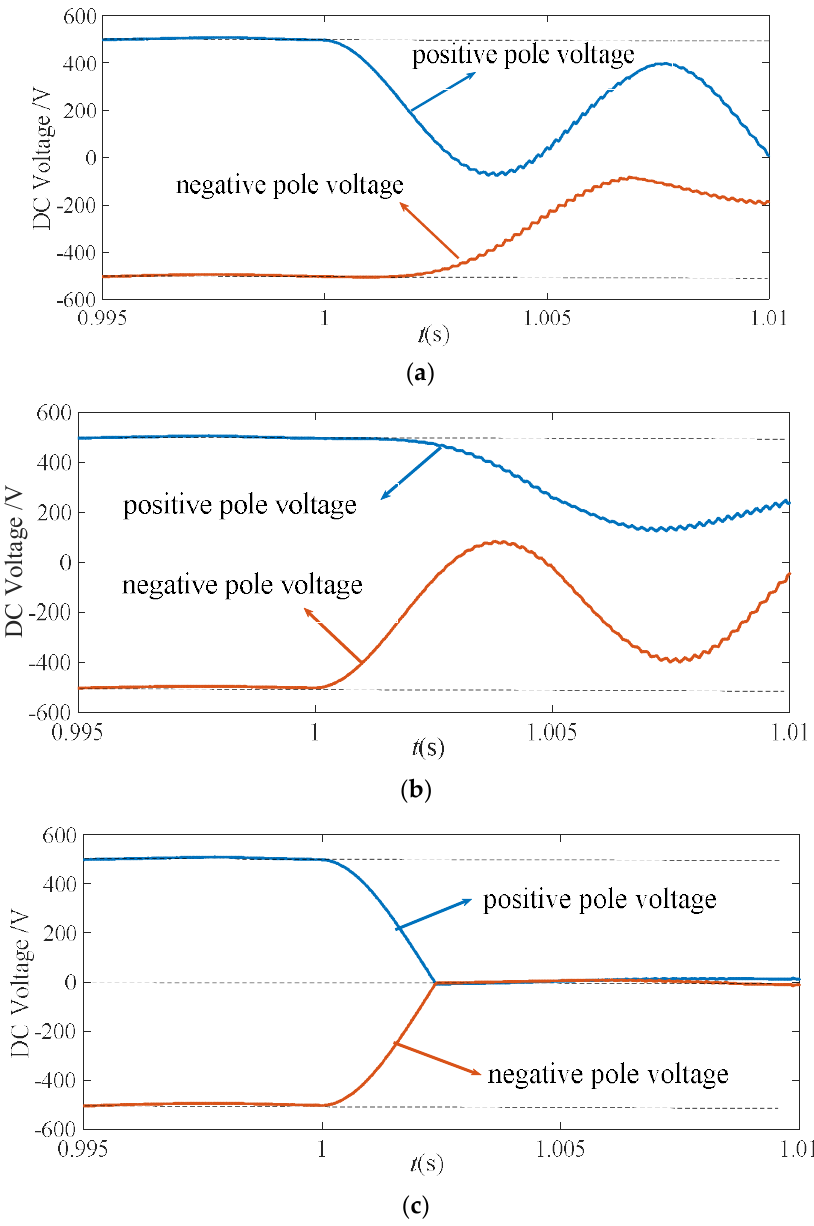
Figure 10. Features of DC voltage of positive and negative poles during different fault types: ( a ) Positive-pole-to-ground fault; ( b ) Negative-pole-to-ground fault; ( c ) Pole-to-pole fault. The coefficient of the changing rate of pole voltage (CRU) is introduced to quantify the changing characteristics of the transient pole voltage waveform.